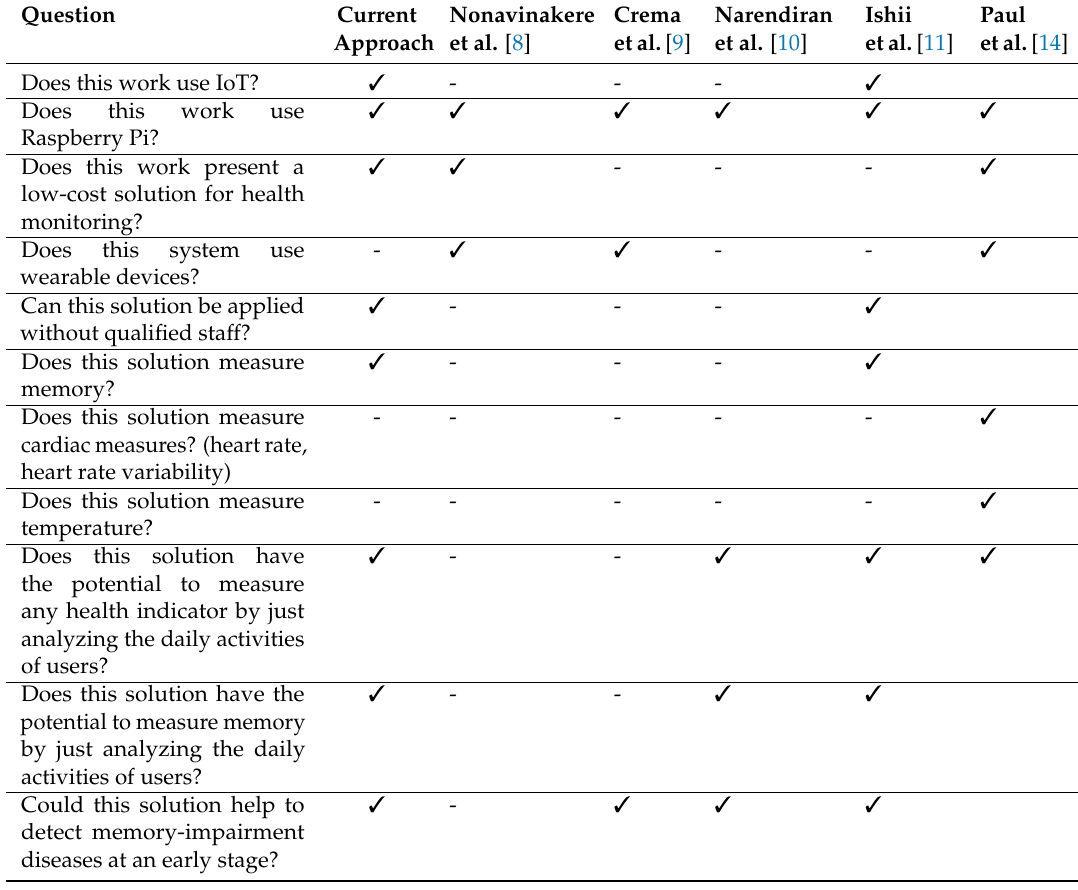
Table 1. Comparison between the current work and the most closely related